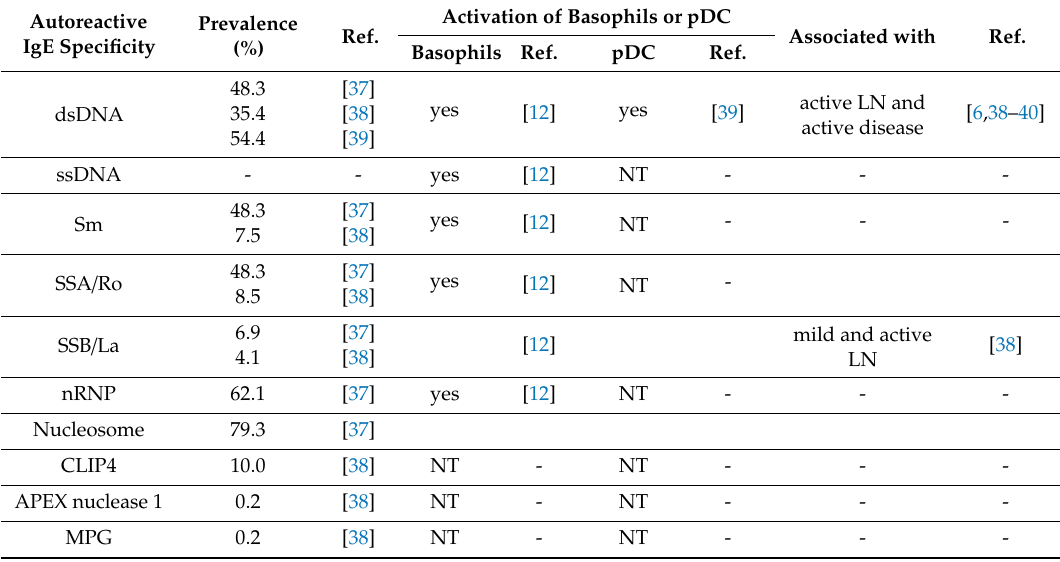
Table1. SpecificitiesofautoreactiveIgEandtheirpathogenicroleinsystemiclupuserythematosus(SLE). Autoreactive IgE